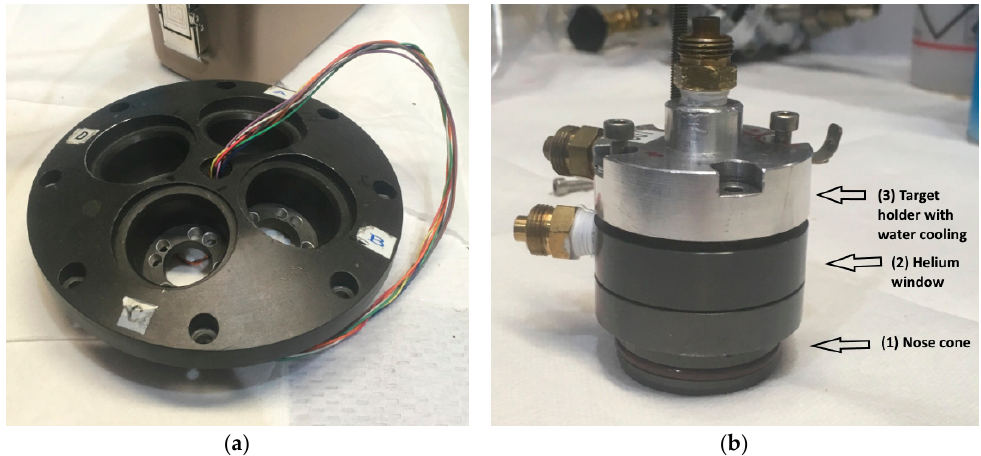
Figure 1. ( a ) TR13 four position target selector. ( b ) Standard TR13 solid target holder.